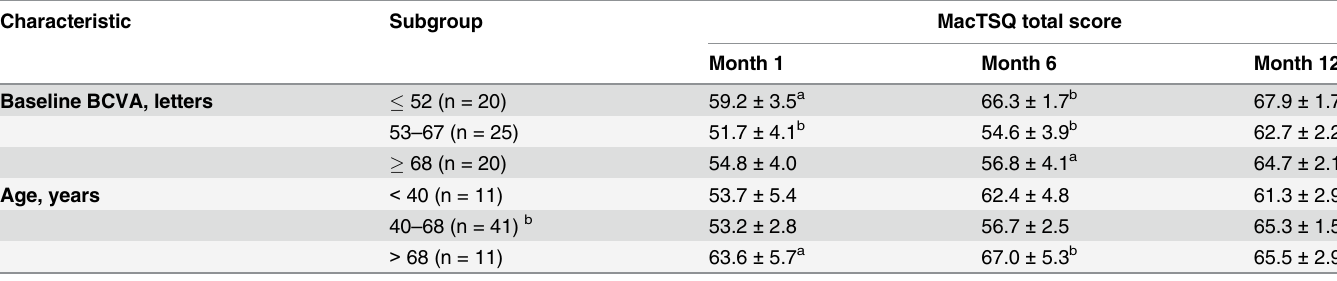
Data are shown as mean ± standard error. a Data missing for one patient. b